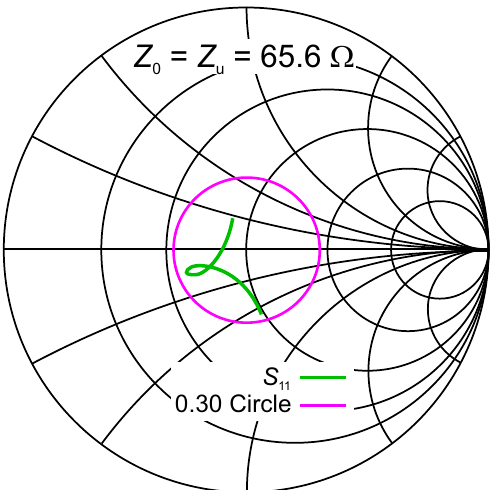
Figure 10. Result of the simulation of Figure9 superimposed to the target circle with radius